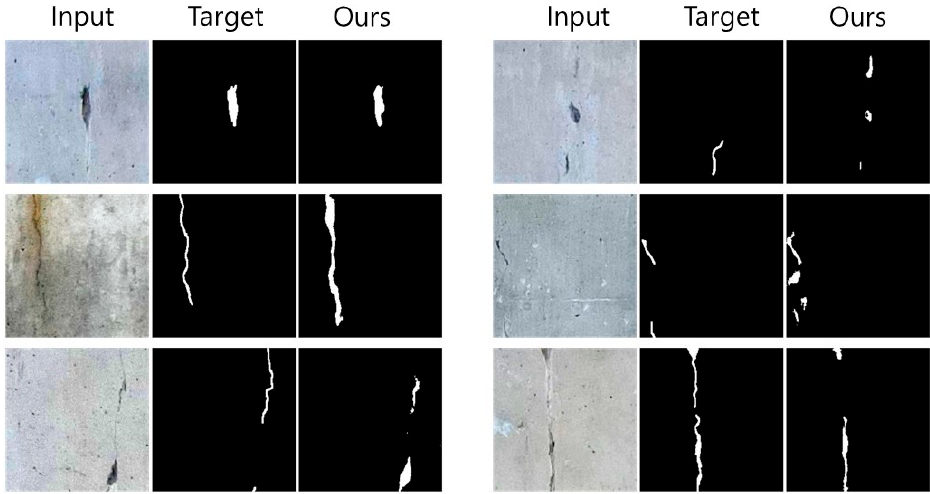
Figure 15. Comparison of segmentation results between labeled and predicted images.